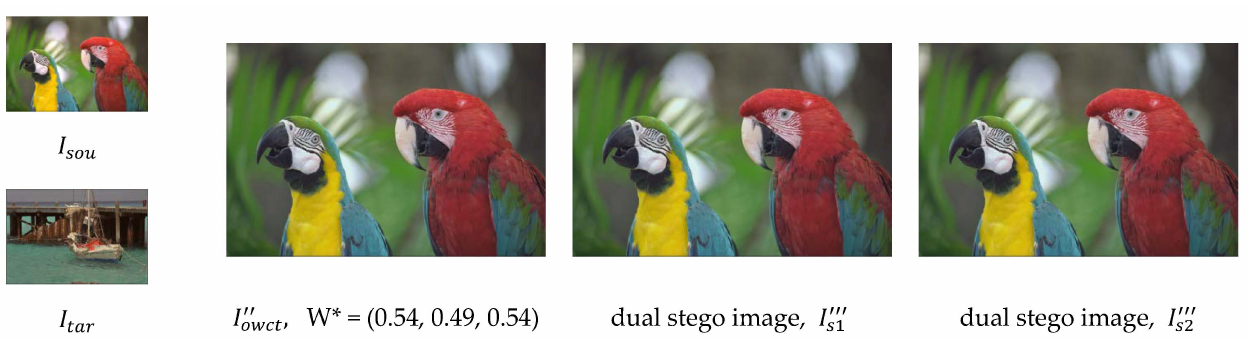
Figure 9. The visual inspection of the test image “Kodim20”.